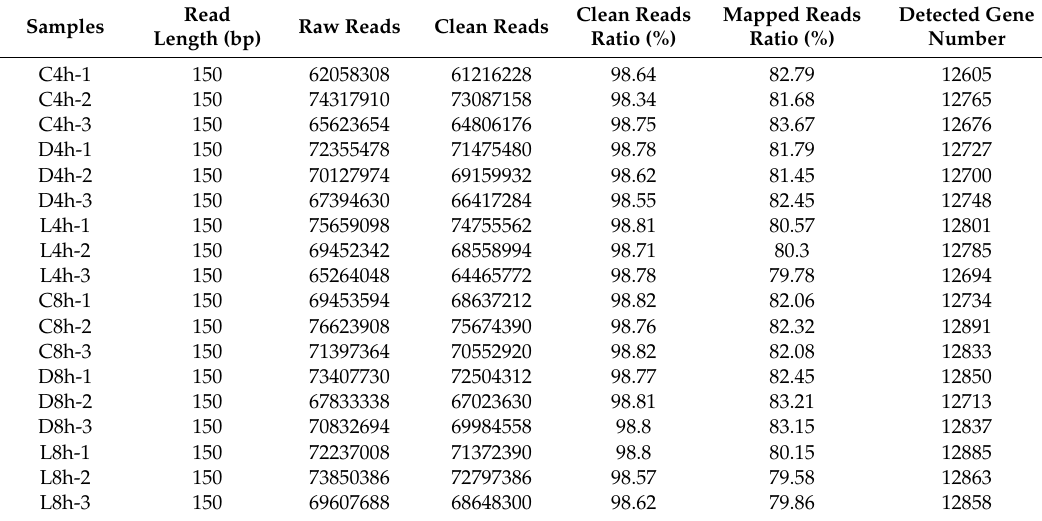
Table 1. Summary of the sequencing data. C, control groups; D, dead E. tarda -treated groups; L, live E. tarda -treated groups; 4 h, 4 h post infection (hpi); 8 h, 8 hpi. Each sample was triplicated as indicated by the number after the hyphen, e.g., C4h-1, C4h-2, and C4h-3. Samples